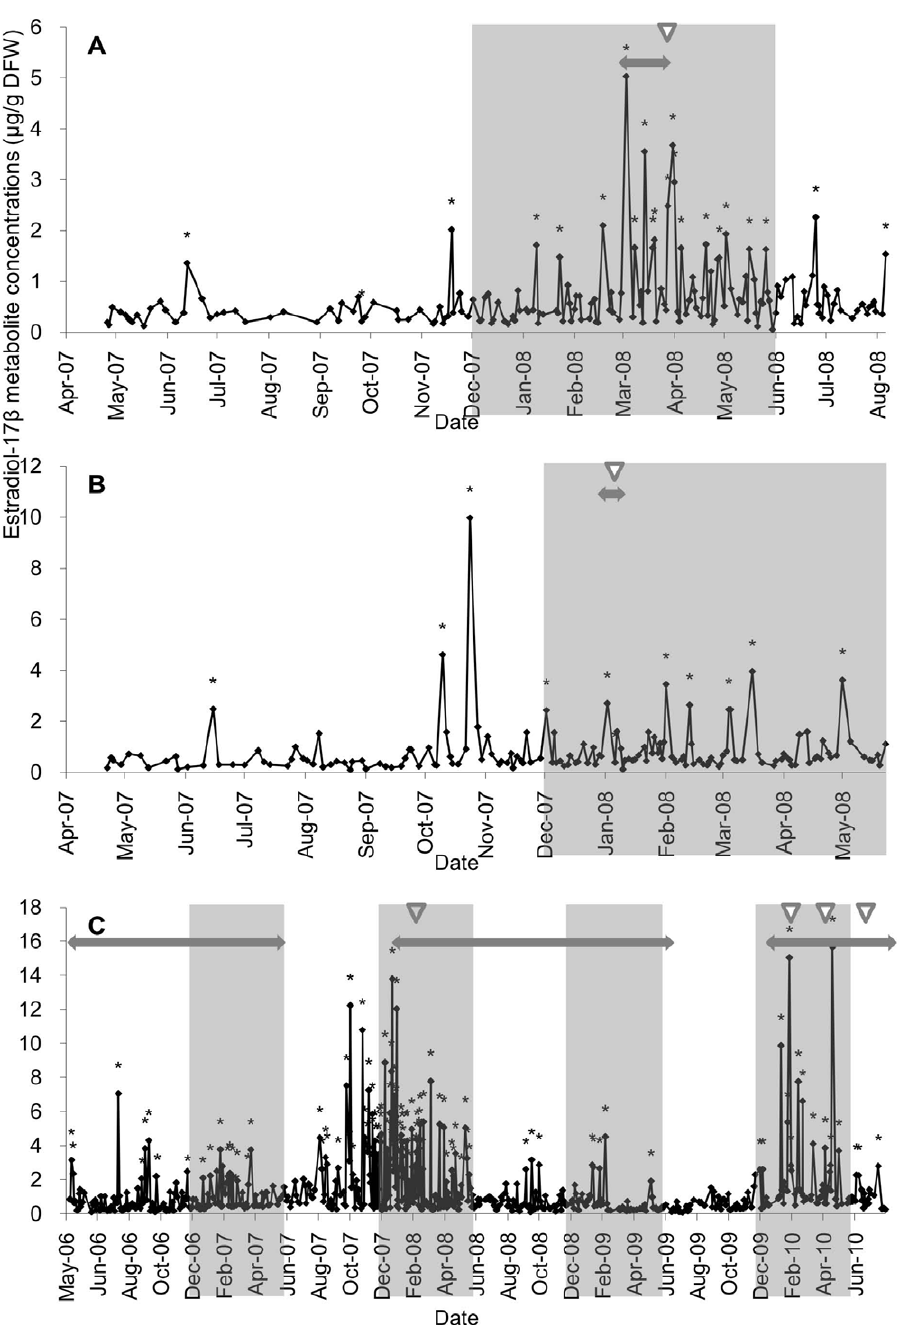
Figure 1. Daily fecal estradiol-17 b metabolite concentrations in three female snow leopards (A: female A, B: female B, C: female C). The shaded areas represent the breeding season, (i.e., December to May). The two-headed arrows show the period that the female was housed with a male, white arrowheads show the day of last copulation. The asterisks indicate the estradiol-17 b metabolite peaks.